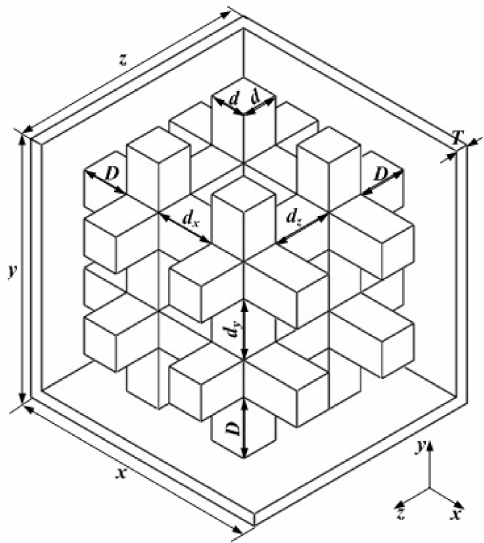
Figure 3. Diagram of the structural parameters of the modified storage tank.